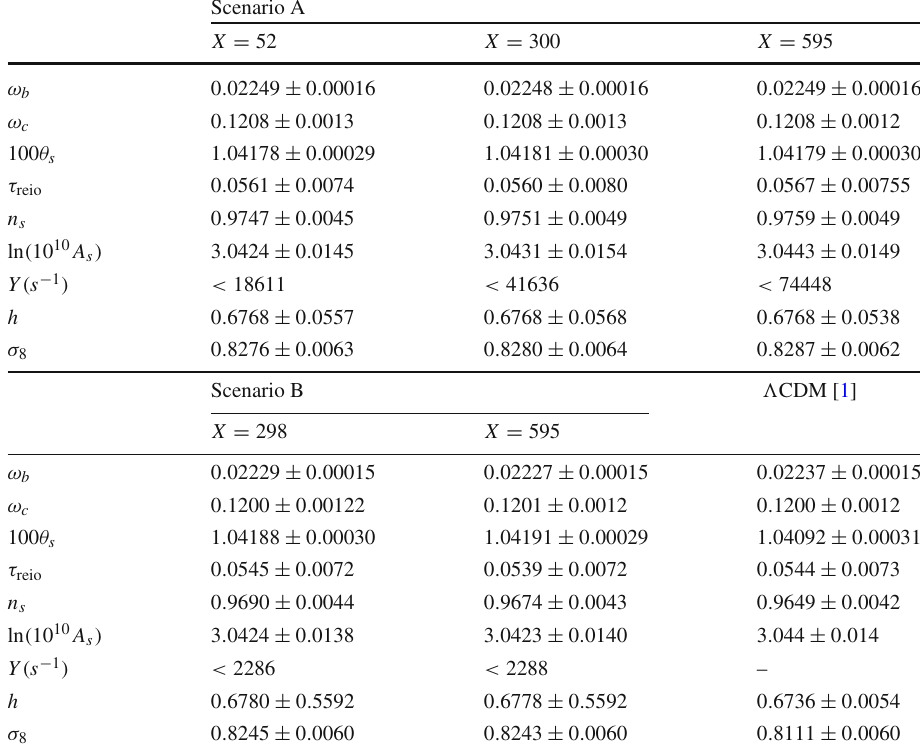
marginalised 68% credible intervals for the base (cid:7) CDM parameters and the marginalised one-sided 95% credible limits on the effective transport rate Y derived from the Planck 2018 CMB data combination TTTEEE+lowE+lensing [1], for fixed values of the effective mass parameter X in scenarios A and B. The vanilla (cid:7) CDM estimates are taken from Ref.